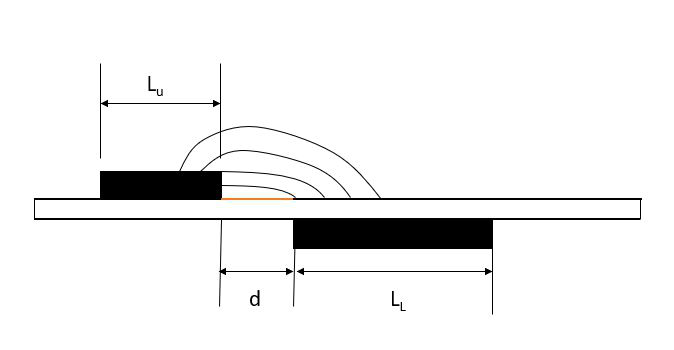
Figure 2. Electric field distributions in the actuator